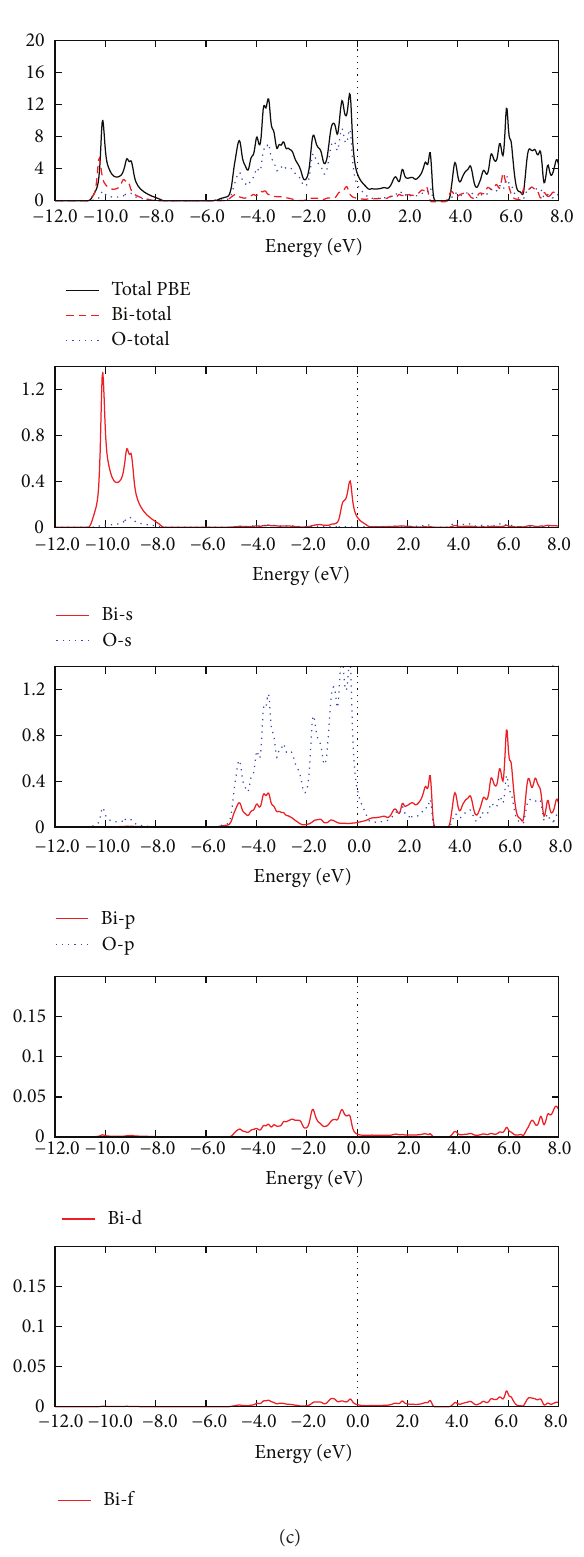
Figure 4: Total and projected density of states (DOS) for 𝛿 -Bi 2 O 3 for the case when spin-orbit interaction is considered and using functionals (a) LDA, (b) B3PW91, and (c)